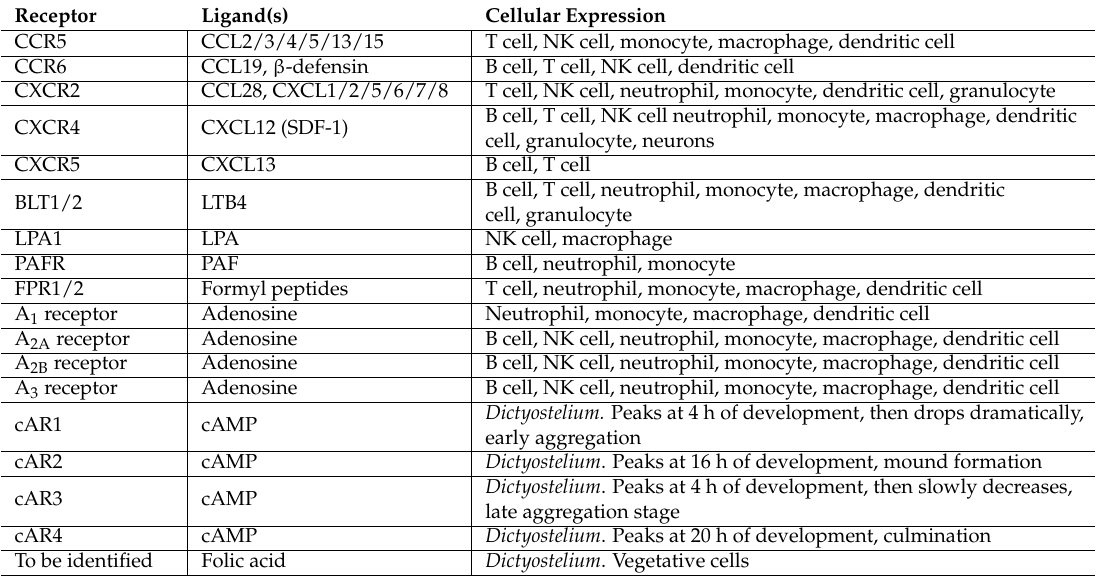
Table 1. Overview of chemotaxis receptors discussed in this review, their respective ligands and expression profiles. NK cell: Natural Killer